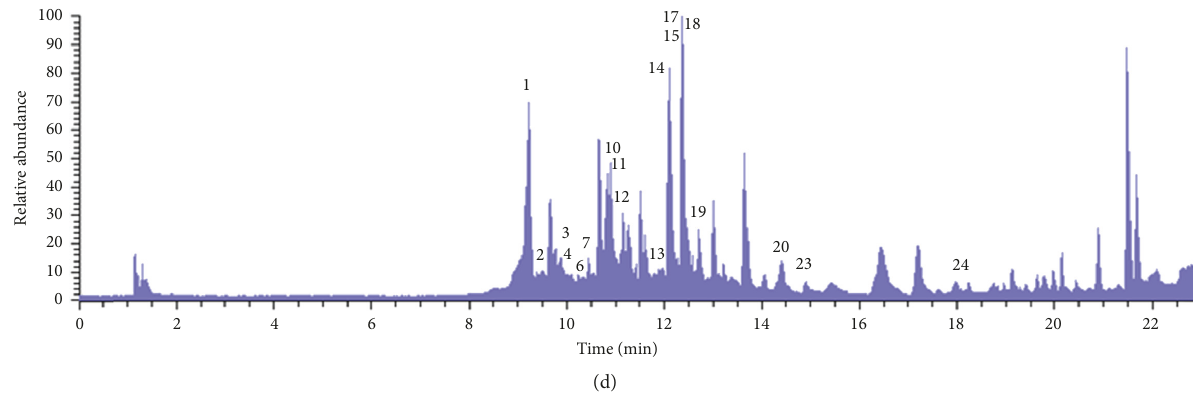
Figure 2: UHPLC-chromatograms of (a) peel, (b) flower, (c) gel, and (d) root from Northern Chilean A. vera